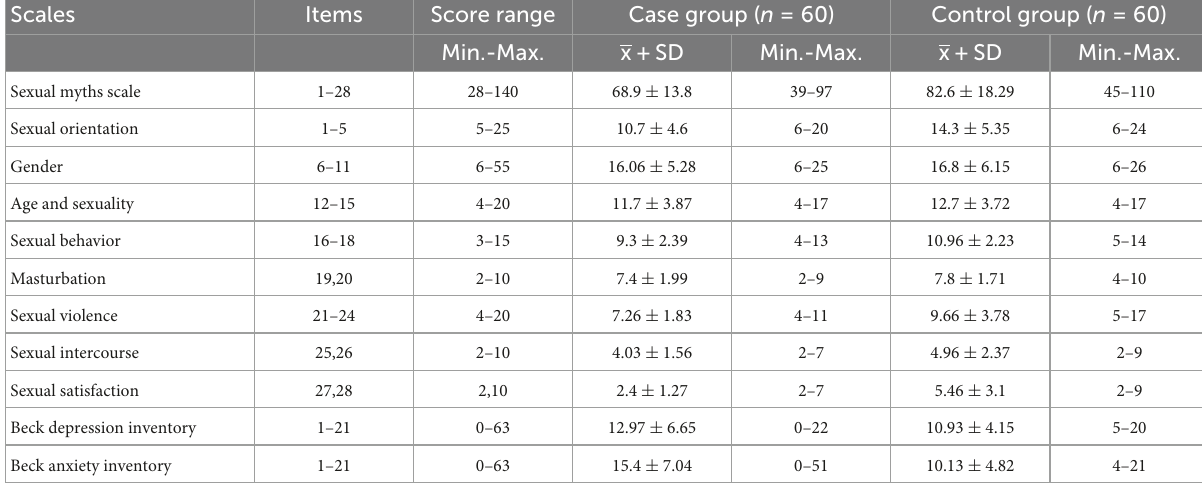
TABLE 2 Mean sexual myths scale (SMS), Beck depression inventory (BDI), and Beck anxiety inventory (BAI) scores of case and control groups ( N = 120). Scales Items